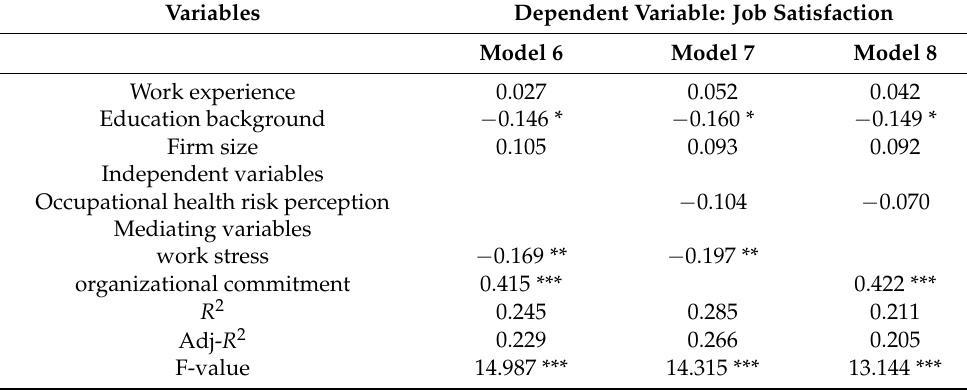
Table 4. Results of the regression analysis (model